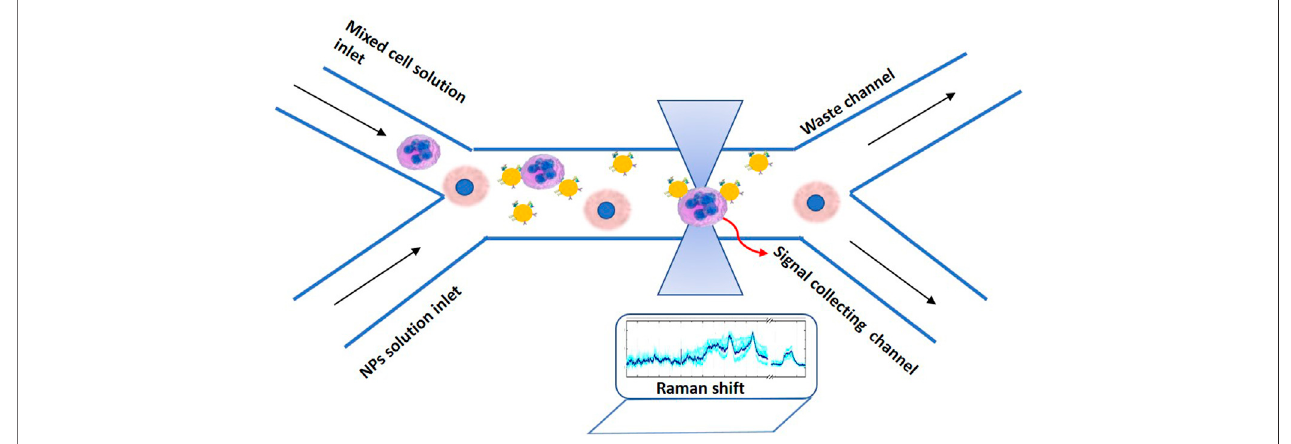
FIGURE 4 | Schematic representation of dual-beam optical tweezers coupled with micro fl uidics device to manipulate and recognize targeted with functionalized NPstumourcellsfromhealthycells.Thesystemcanbeintegratedwithotherspectroscopicset-upssuchasaRamanmicroscopetocollectsignalsforcelldiscrimination and